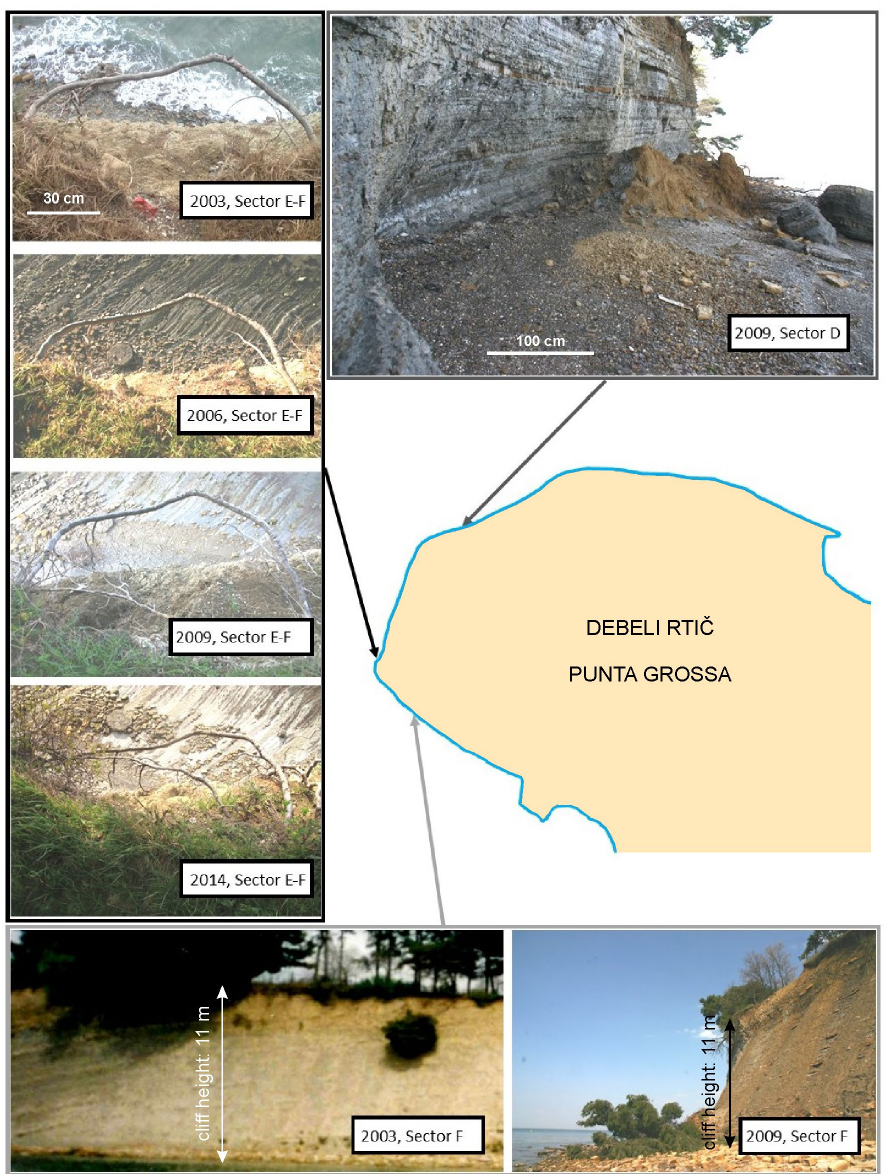
Figure 14. Selected images collected between 2003 and 2014 at the promontory of Debeli Rtič/Punta Grossa. Sea cliff retreat processes are highlighted by slope failures that occurred during the studied period.